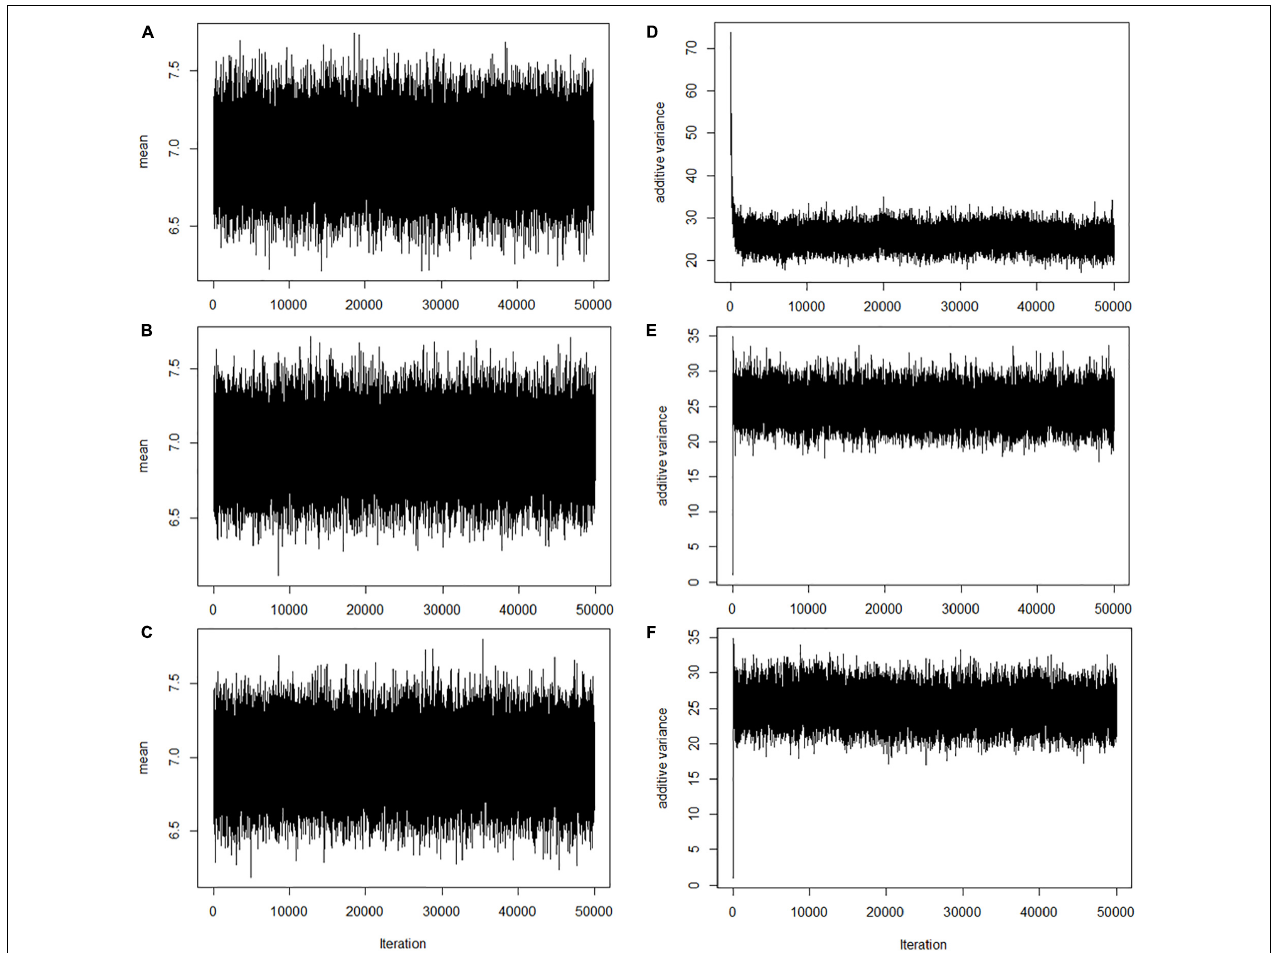
FIGURE 1 | Trace plots of overall mean and additive variance for BayesHP and BayesHE. (A–C) Trace plots of overall mean for BayesHP, BayesHE1, and BayesHE2; (D–F) Trace plots of additive variance for BayesHP, BayesHE1, and BayesHE2.